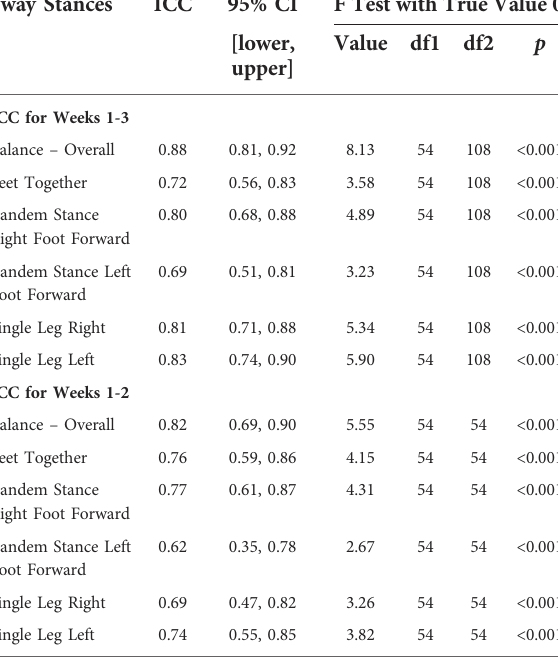
TABLE 3 Test-retest reliability.